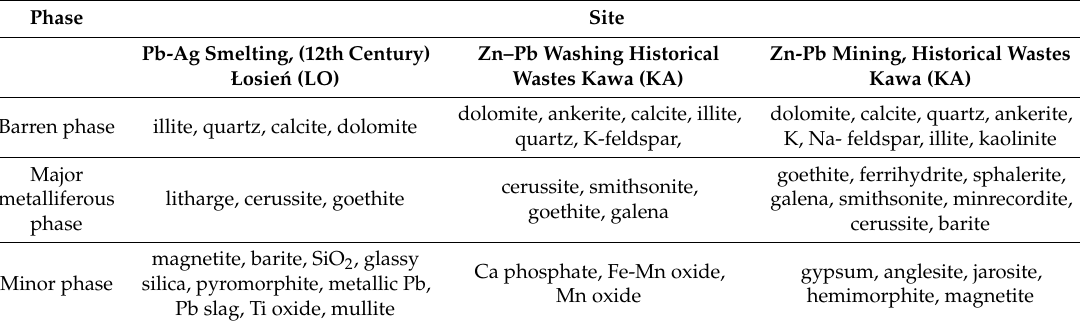
Table 1. Mineral phases detected by selective XRD